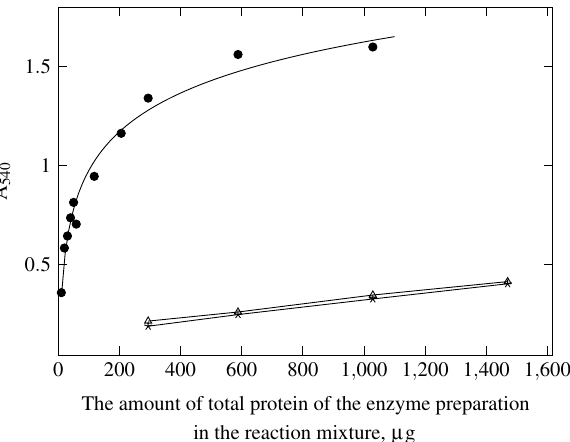
Figure 3. The accumulation of the products of the HA cleavage reaction using the HPC homogenate and the commercial preparation Lydazum depending on the amount of the total protein of the preparation in ◦ the reaction mixture, incubation at 38 C, 20 min, in an acetate buffer (pH 5.62): HPC homogenate, preparation Lydazum, preparation Lydazum (repeat).